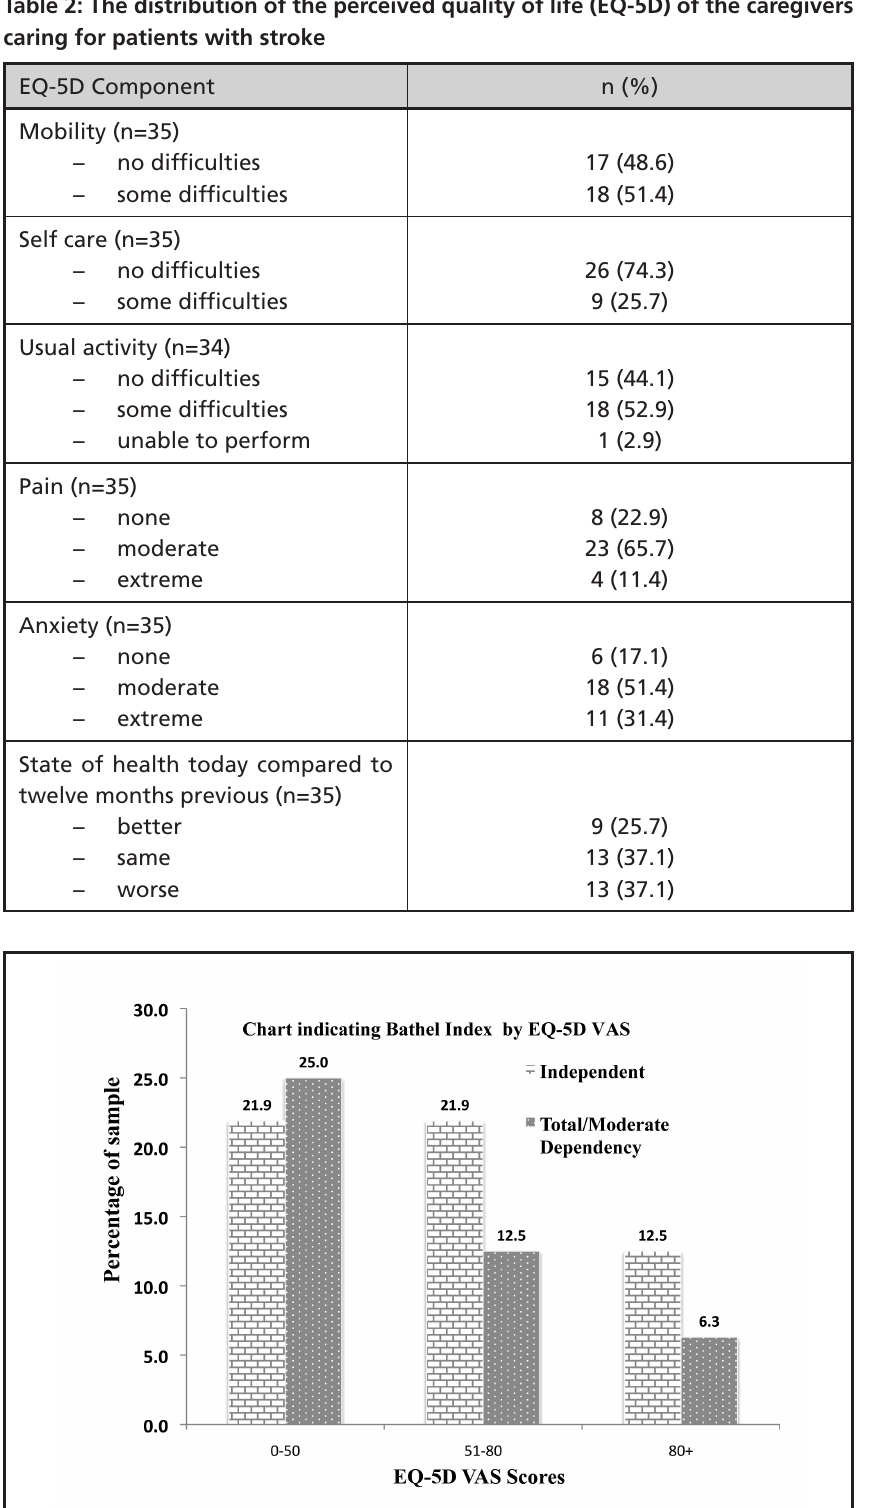
Figure 2: Frequency distribution between BI and EQ-5D